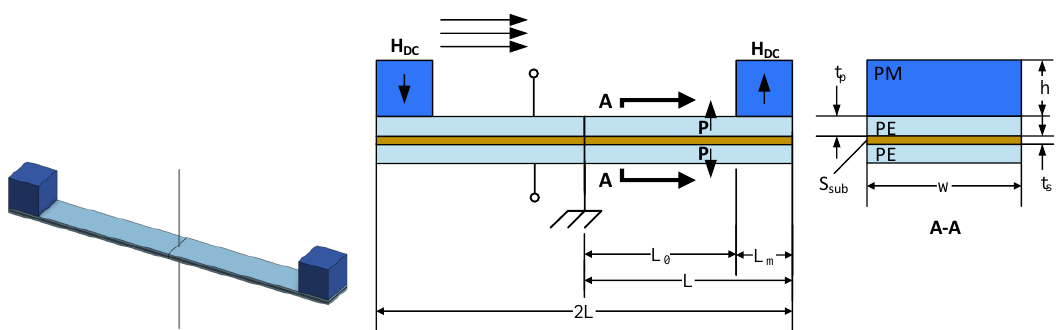
Figure 5. Geometry layout for the double cantilever mechano-magnetoelectric (MME) structure. Arrows marked P indicate PE poling directions and arrows marked H DC indicate the orientation of the permanent magnetic fields.